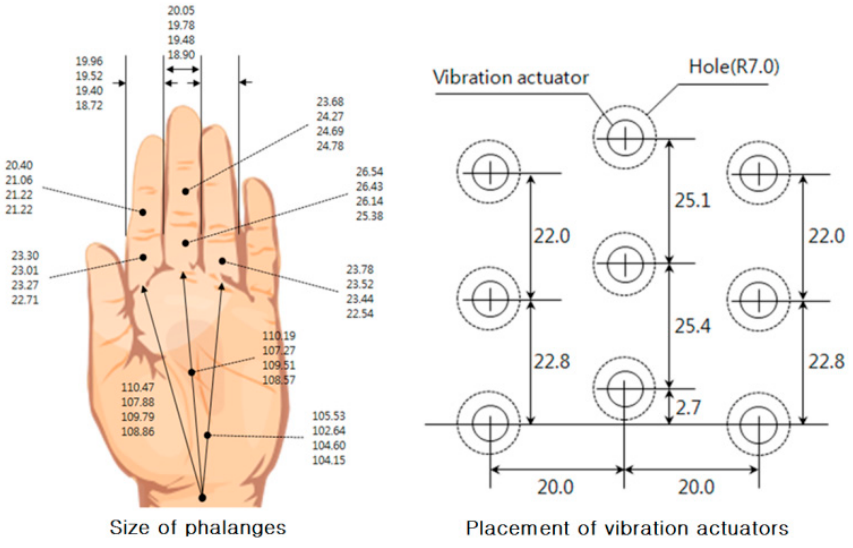
Figure 9. Arrangement of vibrotactile actuators (unit: mm).